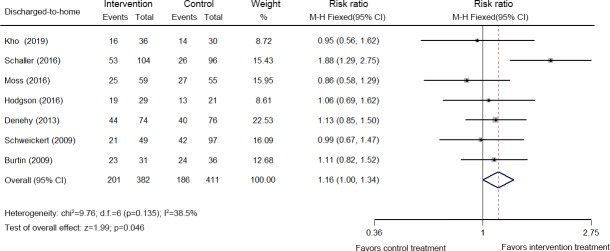
Forest plot of the eligible studies that reported the discharged-to-home rate.